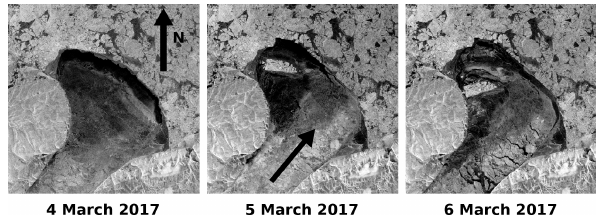
Figure 17. Sequential Sentinel-1 images showing the breakup and drift of an ice piece that was labelled floe no. 39 in this study. This modulated the ice arch. The arrow indicates the dominant wind direction between the acquisition times of the images for 4 and 5